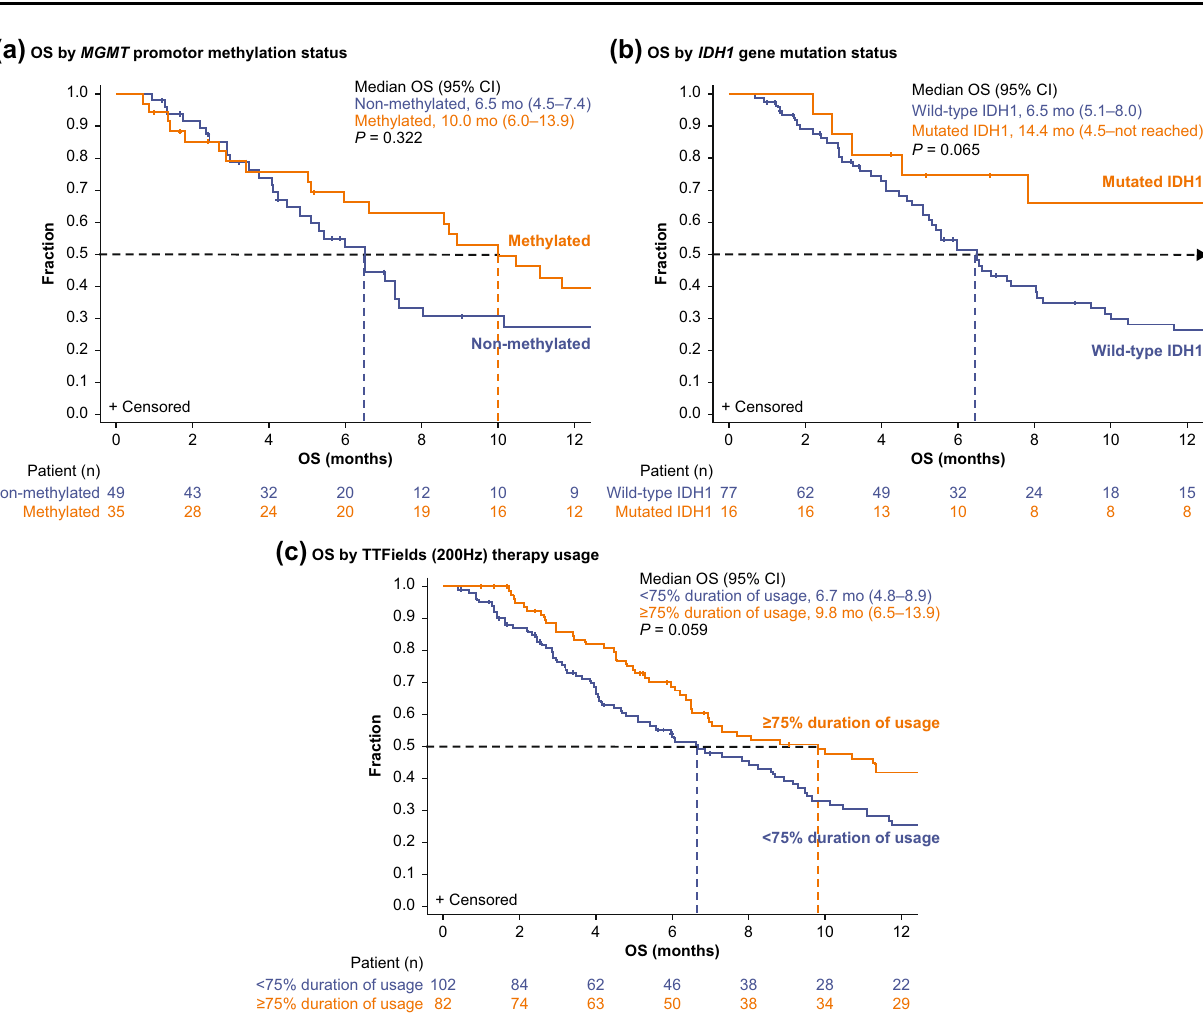
Fig. 3 Comparison of EF-19 registry of patients with rGBM treated with TTFields (200 kHz) therapy in the ITT population by subgroup analyses: a MGMT promotor methylation status (n = 84), b IDH1 gene mutation status (n = 93), and c duration of TTFields treatment usage (n = 184). CI , confidence interval; IDH1, isocitrate dehydrogenase 1; MGMT, O6-Methylguanine-DNA-methyltransferase; OS, overall survival; rGBM, recurrent glioblastoma; TTFields, Tumor Treating